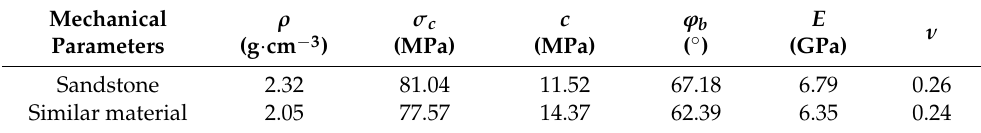
Table 1. Mechanical parameters of sandstone similar material.